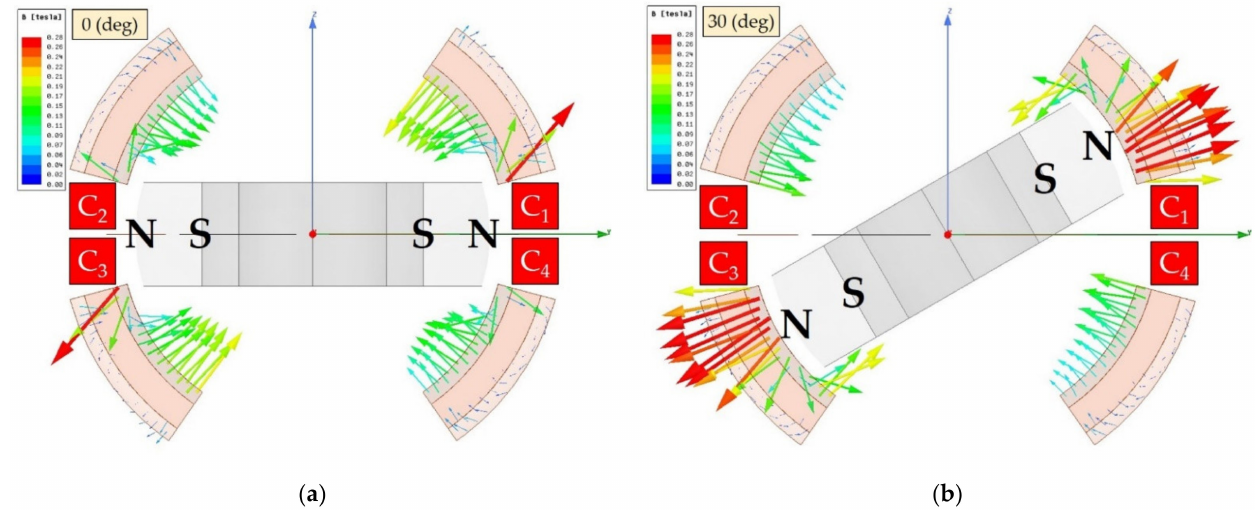
Figure 8. The magnetic field distribution for the rotation about the X -axis when the rotor is tilted at ( a ) 0 ◦ and ( b ) 30 ◦ along the X -axis.